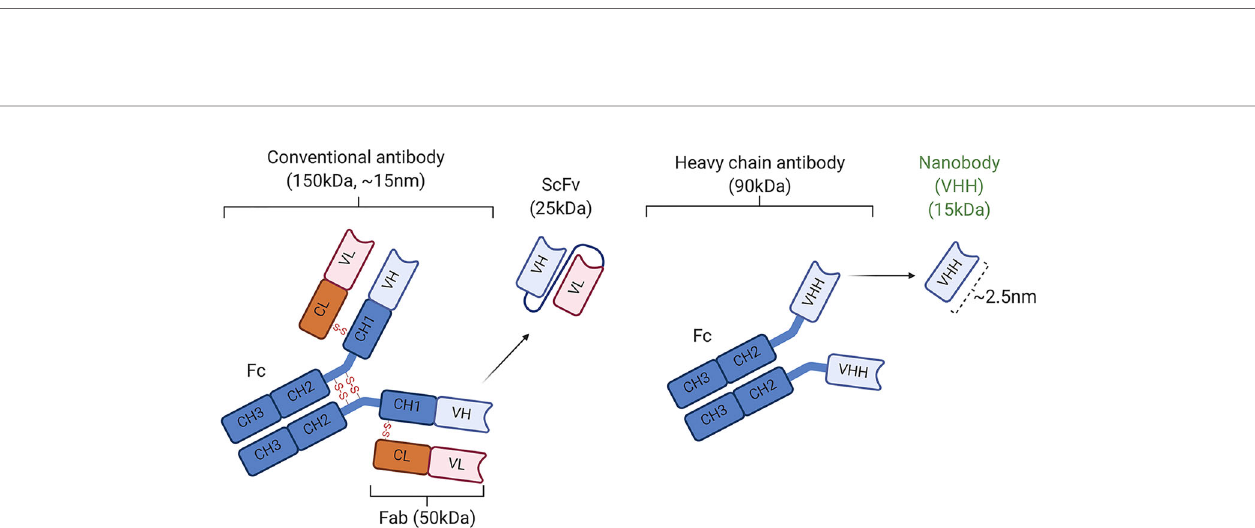
FIGURE 6 | Schematic representation of conventional antibodies (IgG1) containing two light (L) chains (the VL and CL domains) and two heavy (H) chains and nanobodies (16). CH, constant domain of immunoglobulin H chain; Fab, antigen-binding fragment; Fc, crystallizable fragment; scFv, single-chain variable fragment.